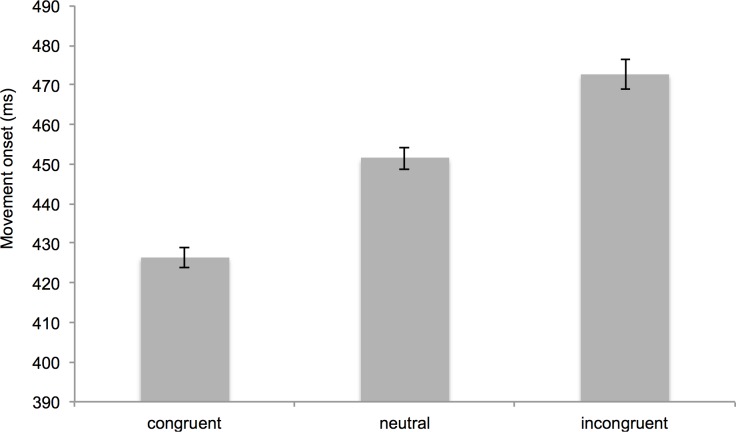
Mean reaction times of the automatic imitation task separated by condition.Error bars represent standard errors of the mean.